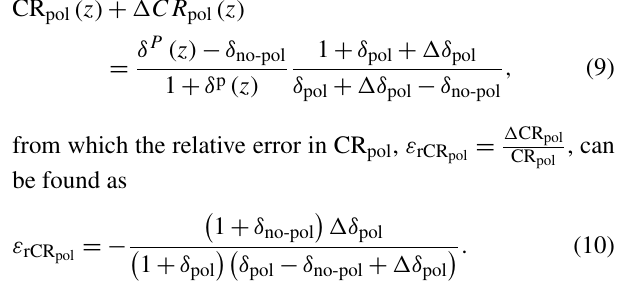
Noh et al. (2013a) used Shimizu’s method with a pollen depolarization ratio equal to that of pure mineral dust, δ pol = 0 . 34, without further